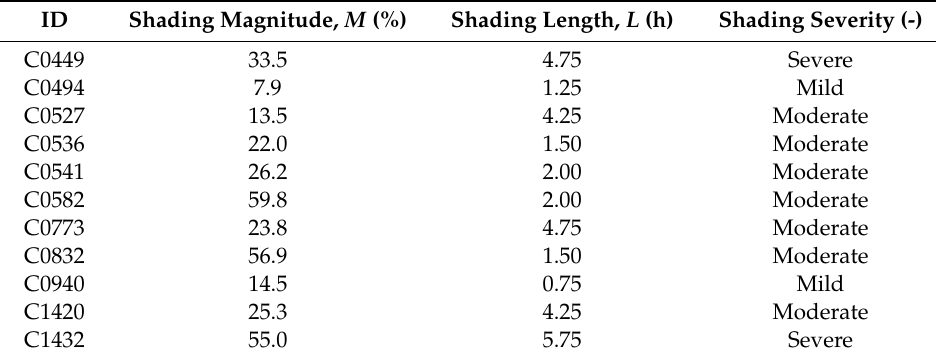
Table 3. Photovoltaic (PV) systems correctly detected with daytime shading under favourable weather conditions, and their respective shading magnitude, shading length and shading